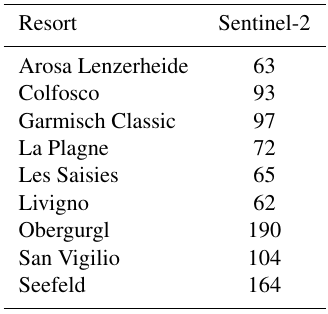
Table A1. Total number of available Sentinel-2 data for each ski